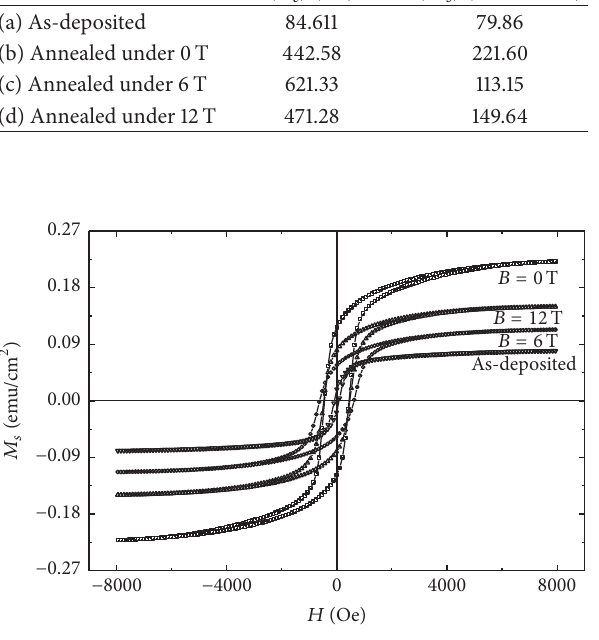
Figure 4: The in-plane hysteresis loops of as-deposited Co-Ni-P film and of the films annealed at 673 K for 4 h under 0T, 6T, and 12 T magnetic field